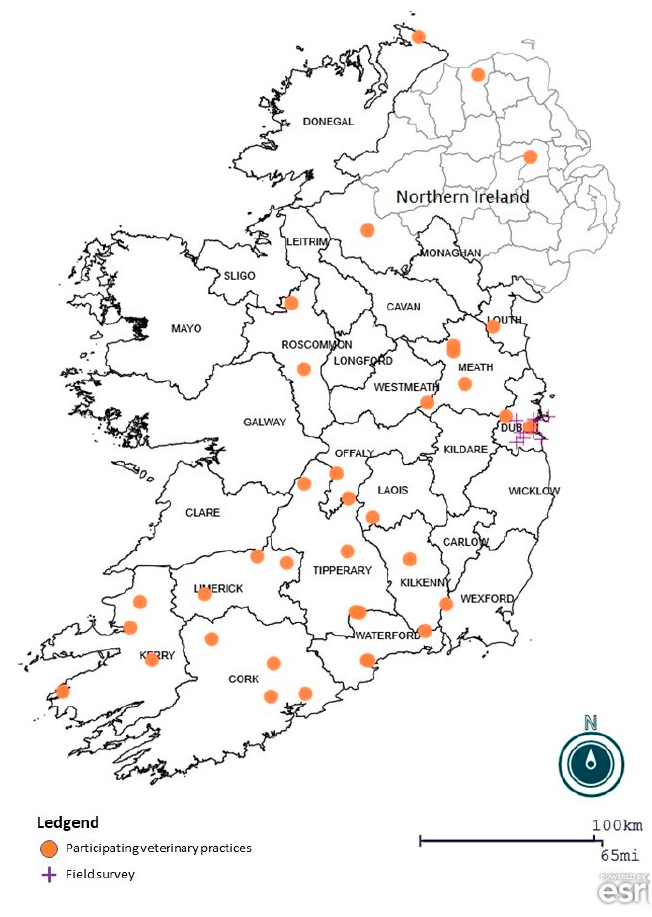
Figure 1. Distribution of participating veterinary practices from which submission were received as well as the field collection sites.